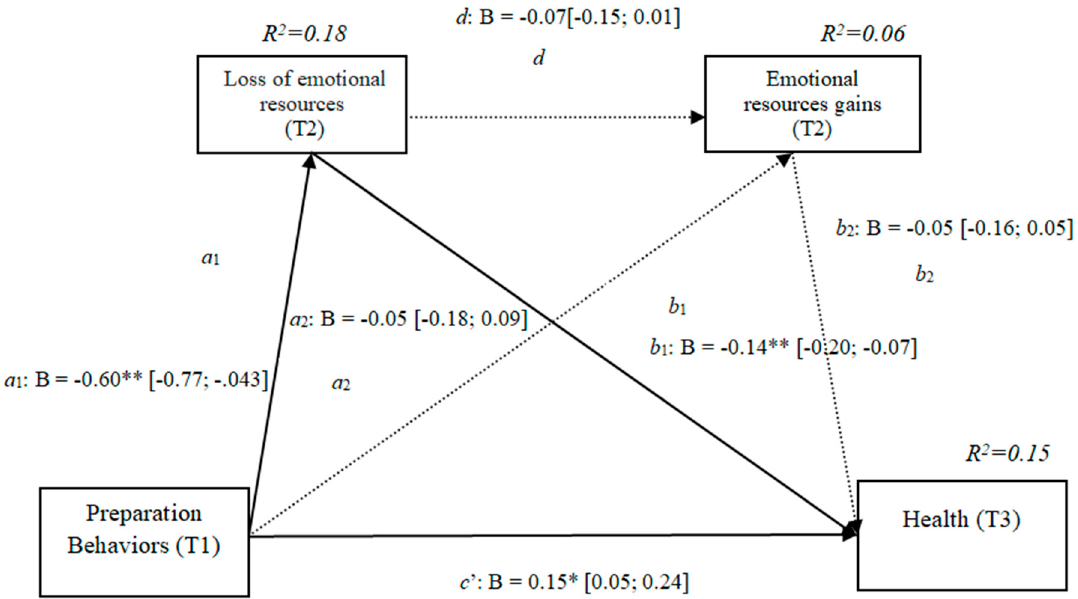
Figure 13. Non-standardized B coefficients, confidence intervals, and statistical significance for emotional losses and gains. [95% CI]; * p < 0.05; ** p < 0.01.